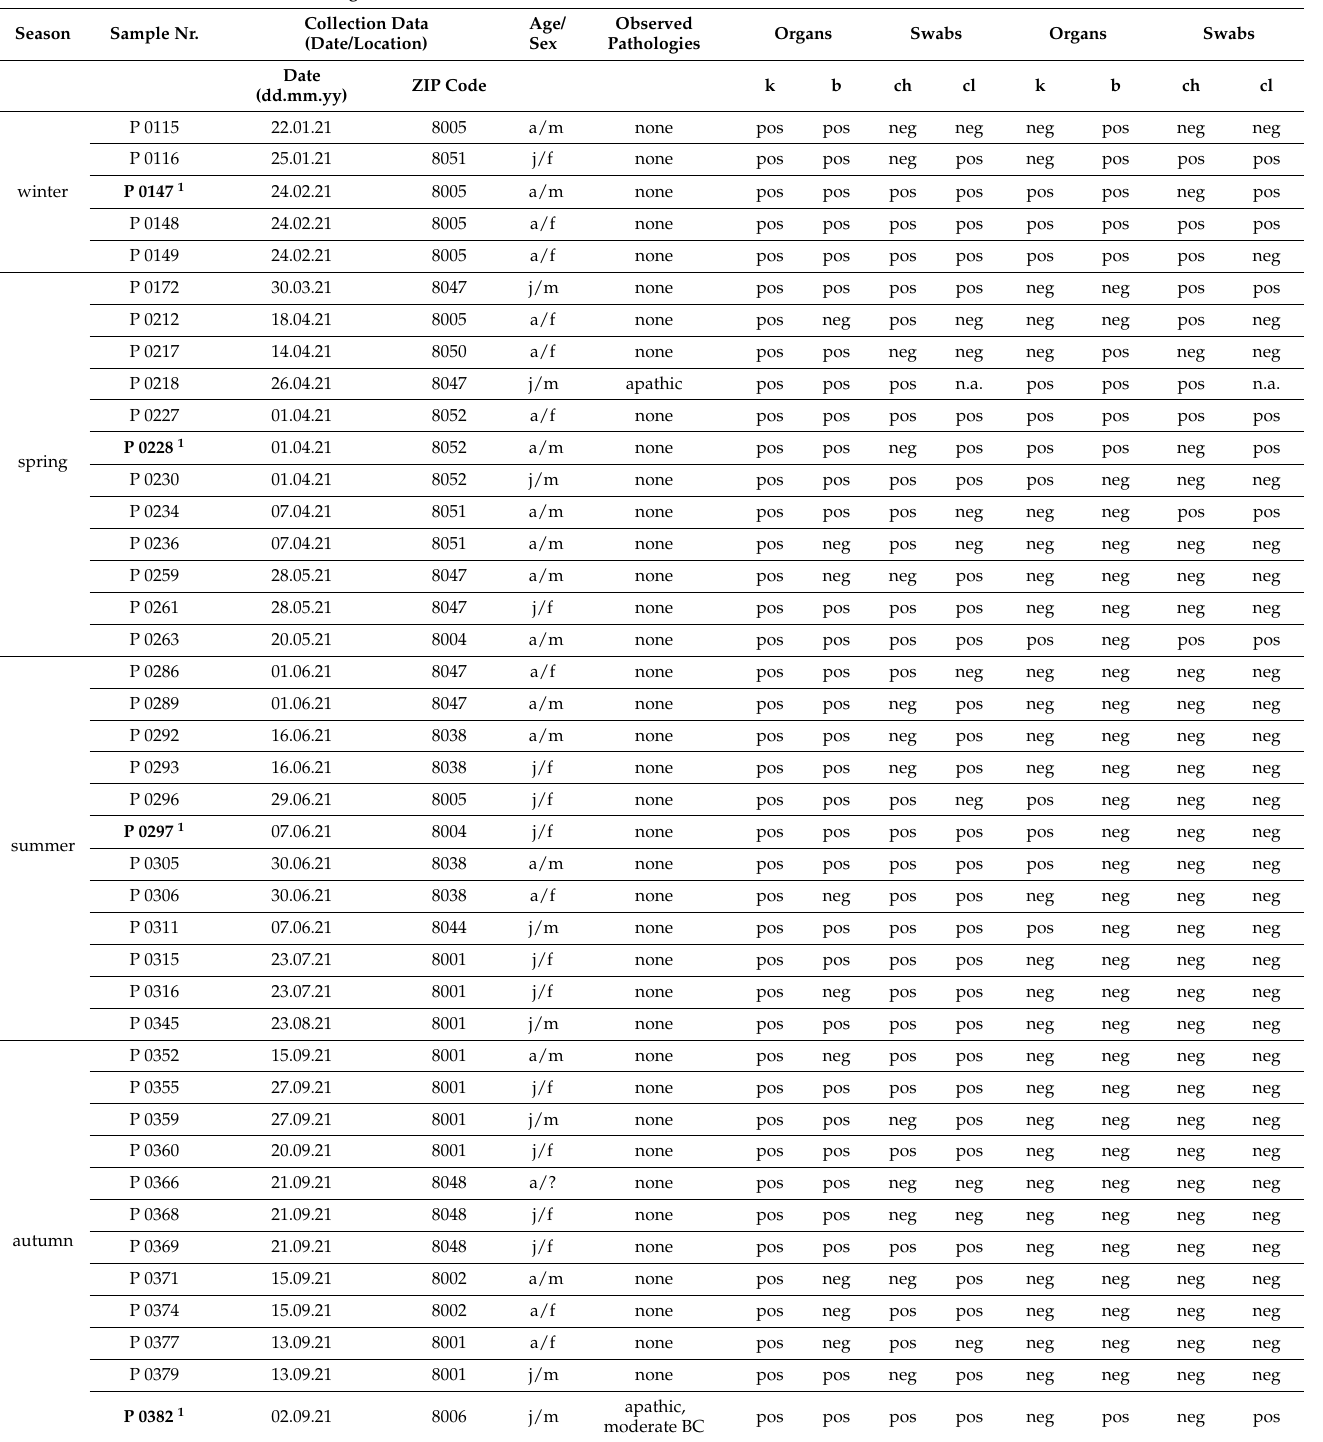
Table A1. Examination of kidney, brain and swab samples from feral pigeons ( Columba livia domestica ) from the city of Zurich by M- and F-gene specific Avian Orthoavulasvirus-1 rRT-PCR. a = adult, j = juvenile; m = male, f = female; k = kidney, b = brain, ch = choana, cl = cloaca, neg = negative, pos = positive, n.a. = not analyzed, BC = body